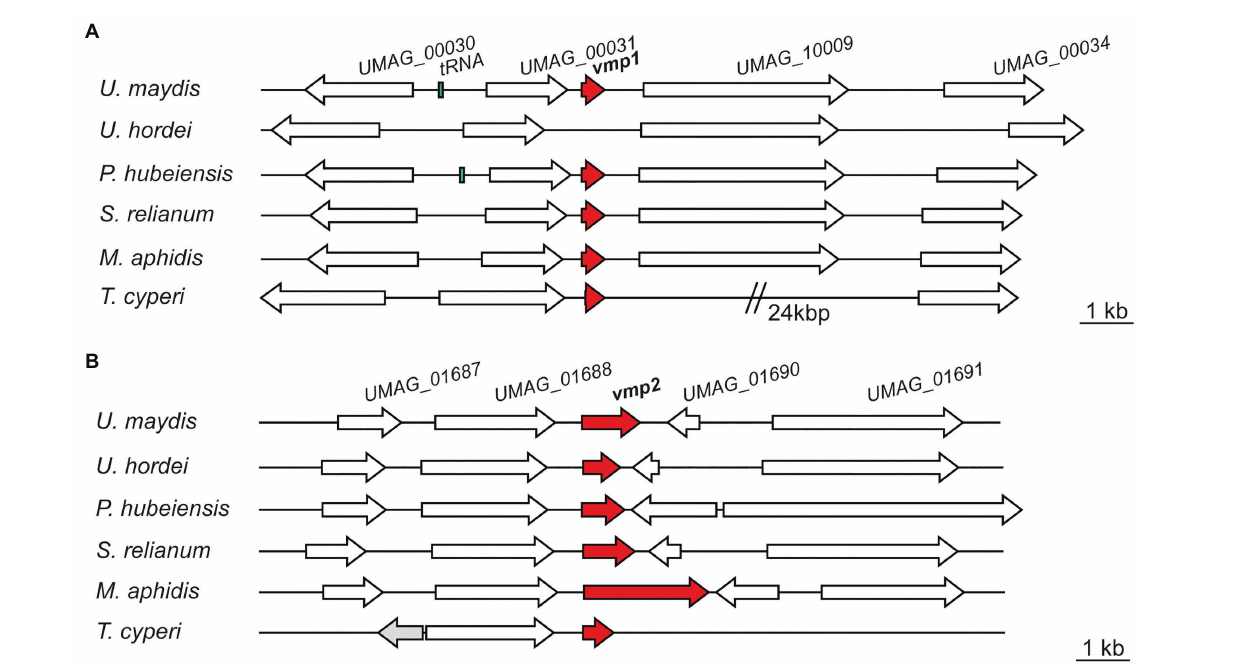
FIGURE 2 | Vmp1 and Vmp2 orthologs are conserved in related smut fungi. Schematic picture of gene loci encoding Vmp1 (A) and Vmp2 (B) and orthologs in the related smut pathogens Ustilago hordei , Pseudozyma hubeiensis , Sporisorium relianum , Moesziomyces aphidis , and Testicularia cyperi . White arrows indicate genes found in all of the respective species, while the gray gene was solely present in the genome of T. cyperi